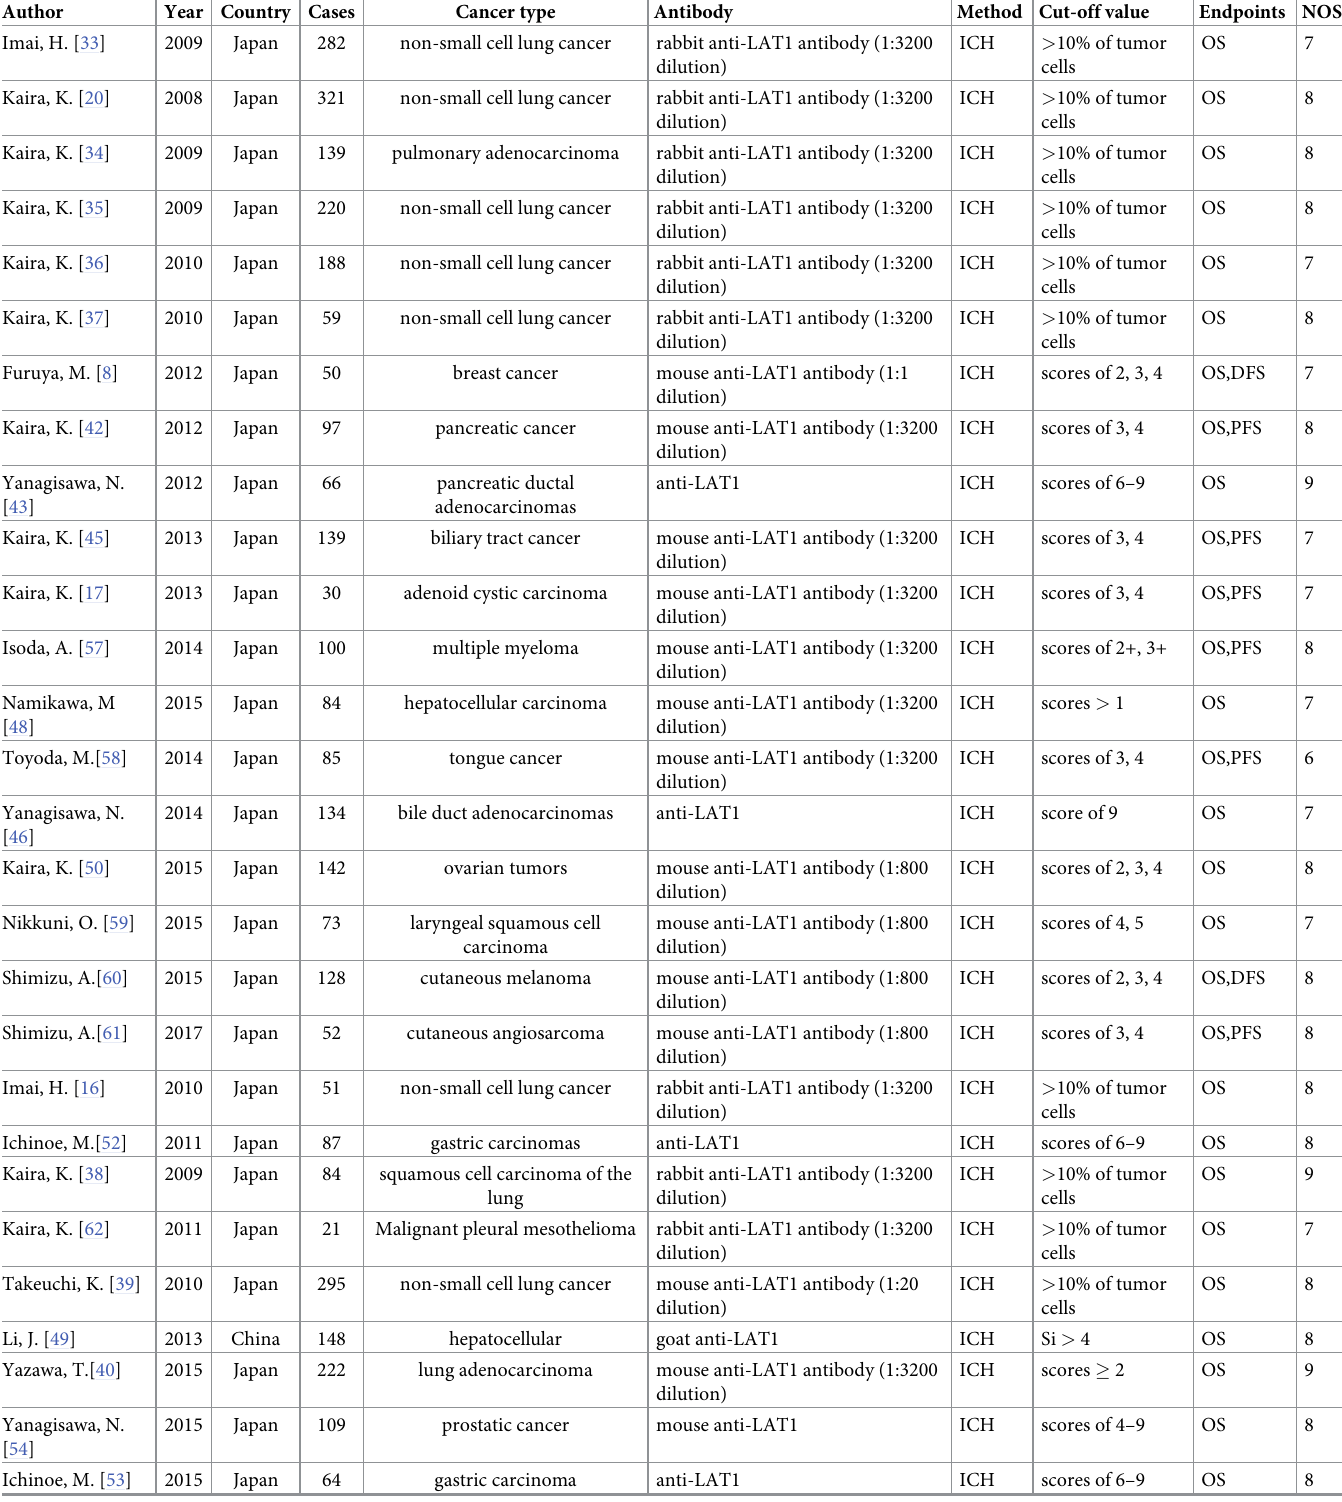
Table 1. Characteristics of studies included in the meta-analysis.